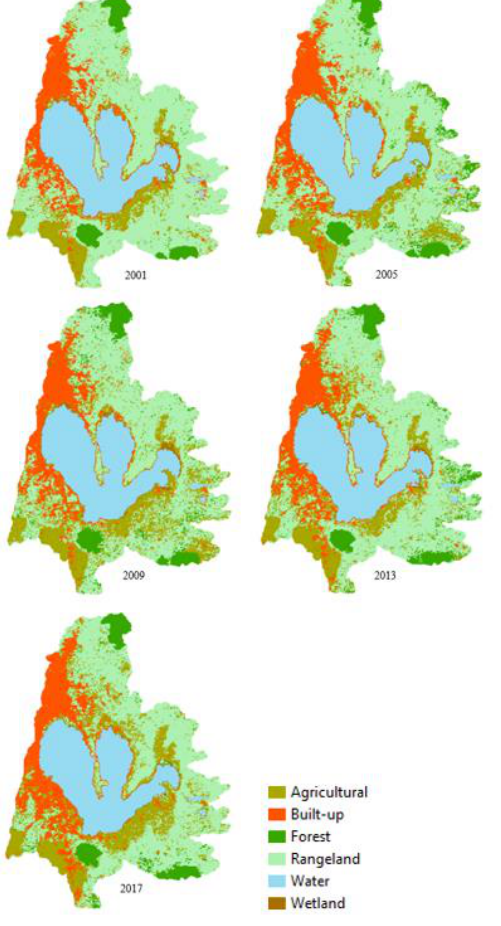
Figure 4. MODIS NDVI-derived land cover maps